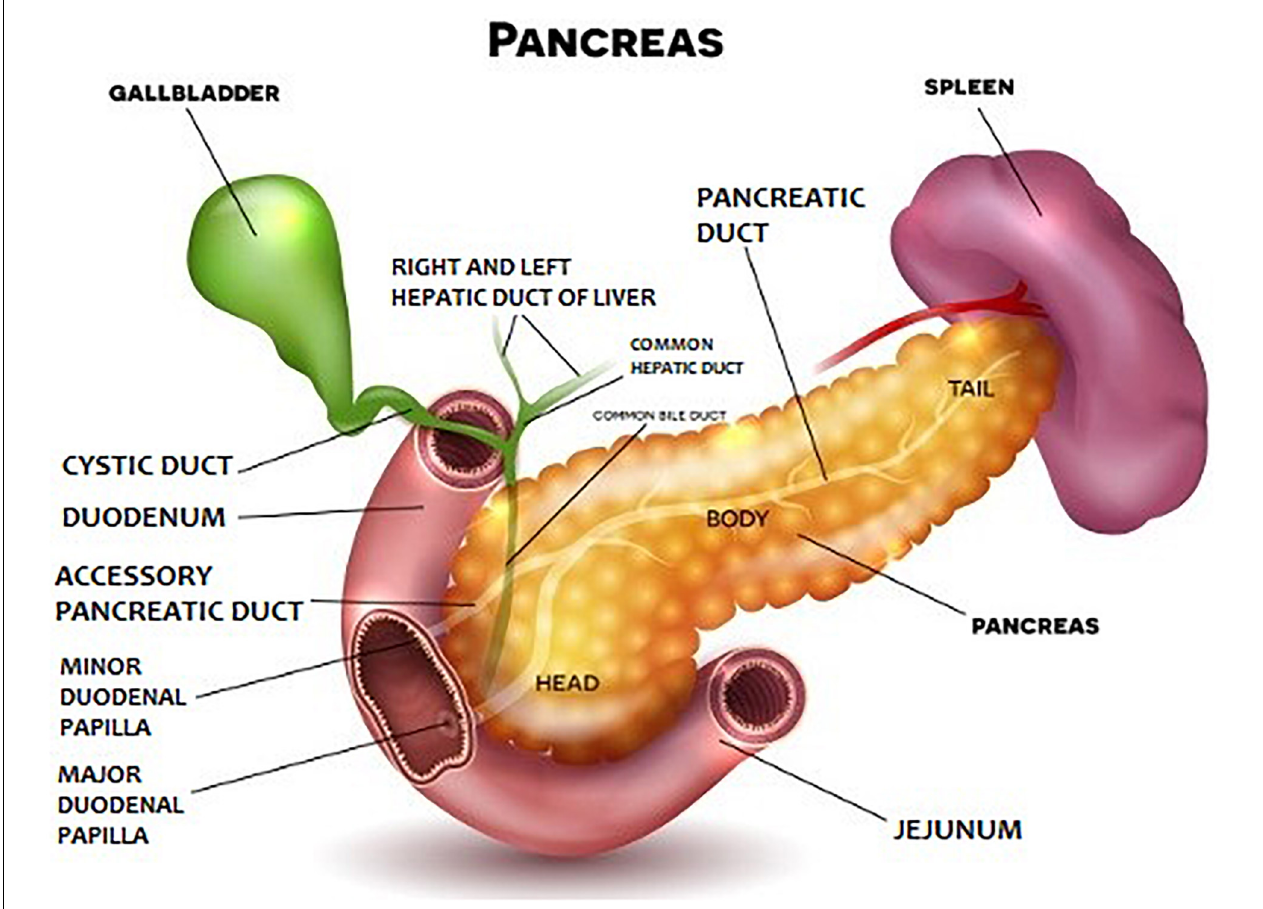
FIGURE 1 | General diagram of the human pancreas